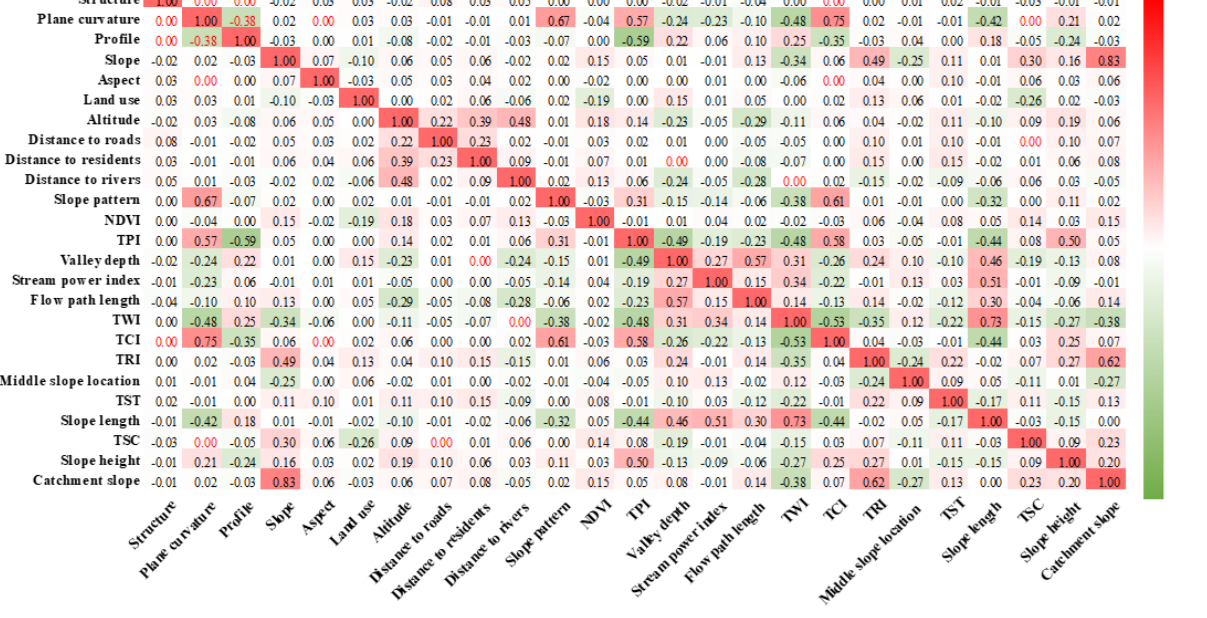
Figure 3. Correlation coefficient matrix of the causative factors of landslides (the black font indicates that the correlation coefficient p value is less than 0.05 and that the correlation is significant) .